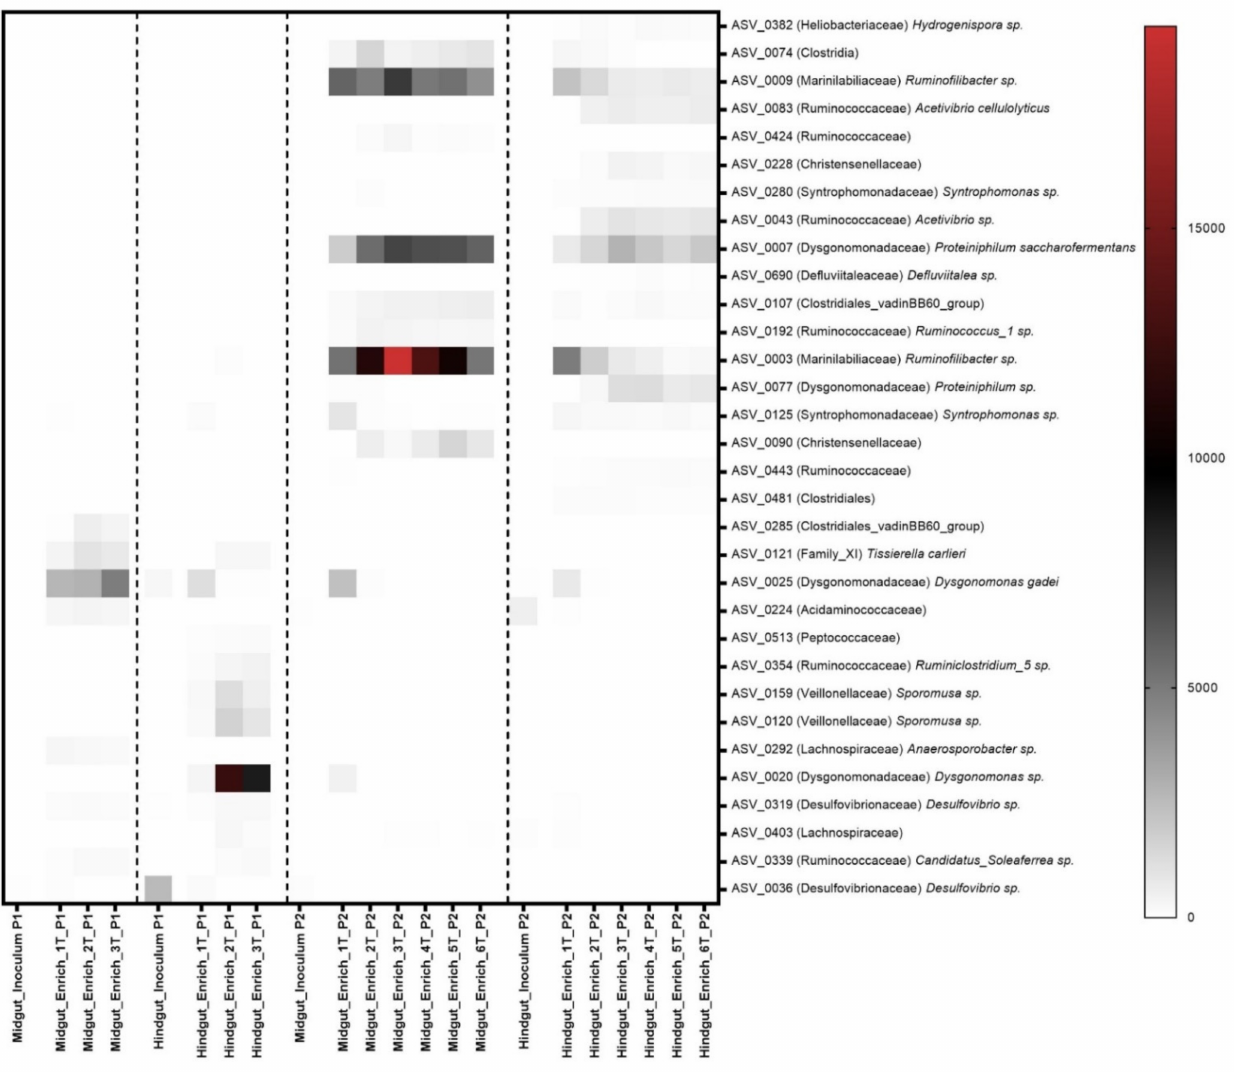
Figure 4. Heat map of the relative abundance of key bioindicator ASVs in enrichment cultures via P1, P2, and their inocula. The ASVs were selected using the random forest machine learning